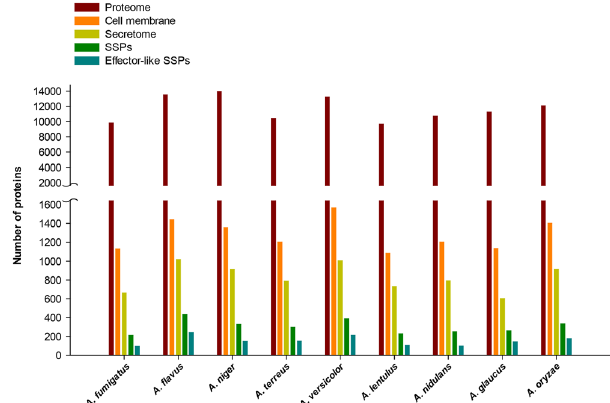
Figure 2. Number of proteins in the complete proteome, set of cell membrane proteins, set of secreted extracellular proteins, set of small secreted proteins (SSPs) and set of effector-like SSPs identified by our computational pipeline in Aspergillus species considered